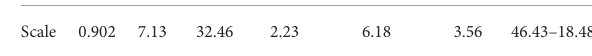
TABLE 7 Results of stability, SEM, responsiveness, and interpretability ( n =